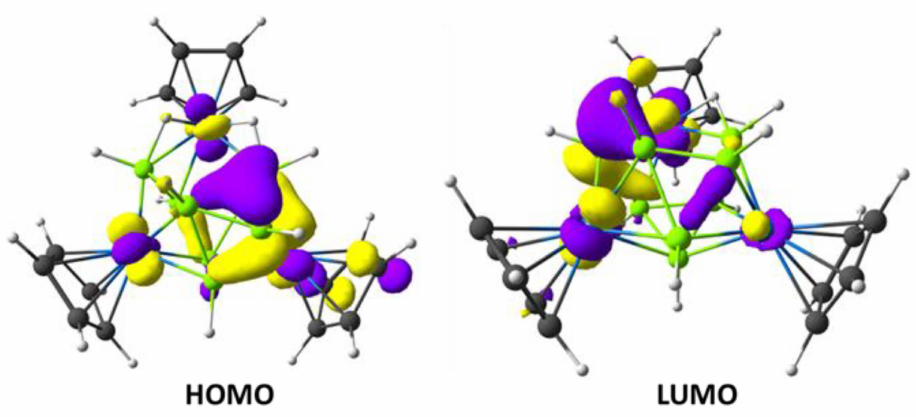
Figure 4. Frontier molecular orbitals of 1’ . Contour value: ± 0.05 [e/bohr 3 ] 1/2